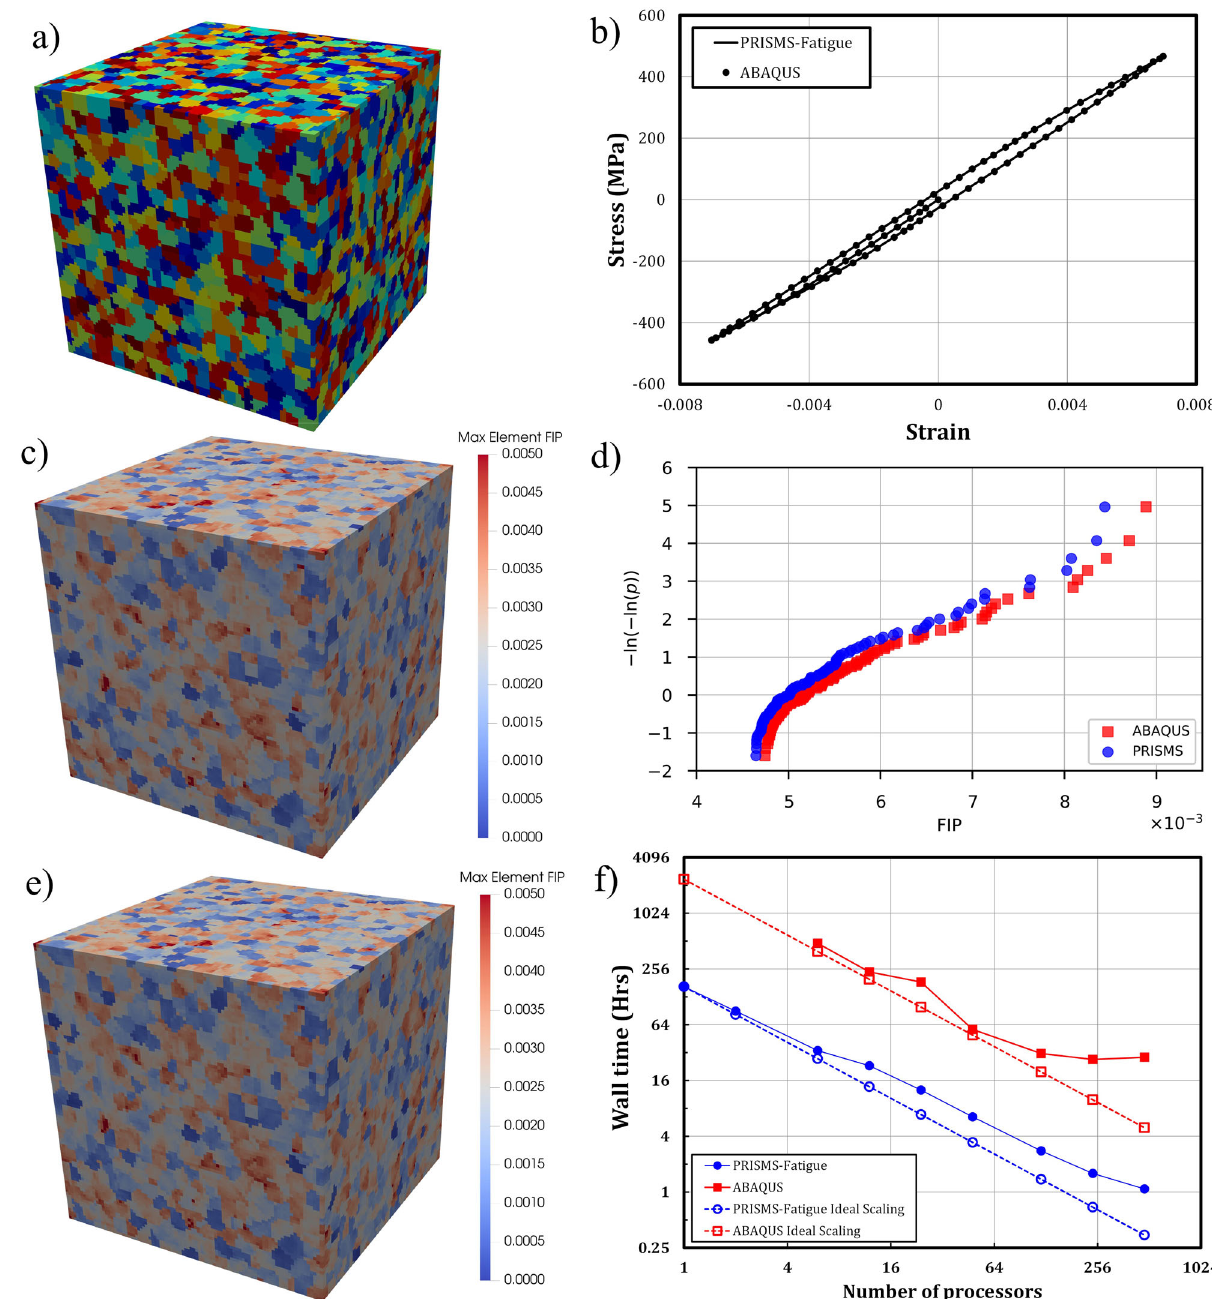
Fig. 2 Comparison between PRISMS-Fatigue and a similar framework implemented in ABAQUS. a Microstructure instantiated with DREAM.3D. b Macroscopic cyclic stress-strain response in both simulation suites. c, e Variation of elemental FIPs in ABAQUS and PRISMS- Fatigue, respectively. Although some elemental FIPs are larger than the legend maximum of 0.005, the purpose is to emphasize the heterogeneity of FIPs throughout the sample. d Comparison of sub-band-averaged (SBA) FIP Extreme Value Distributions (EVDs). f Strong- scaling CPU